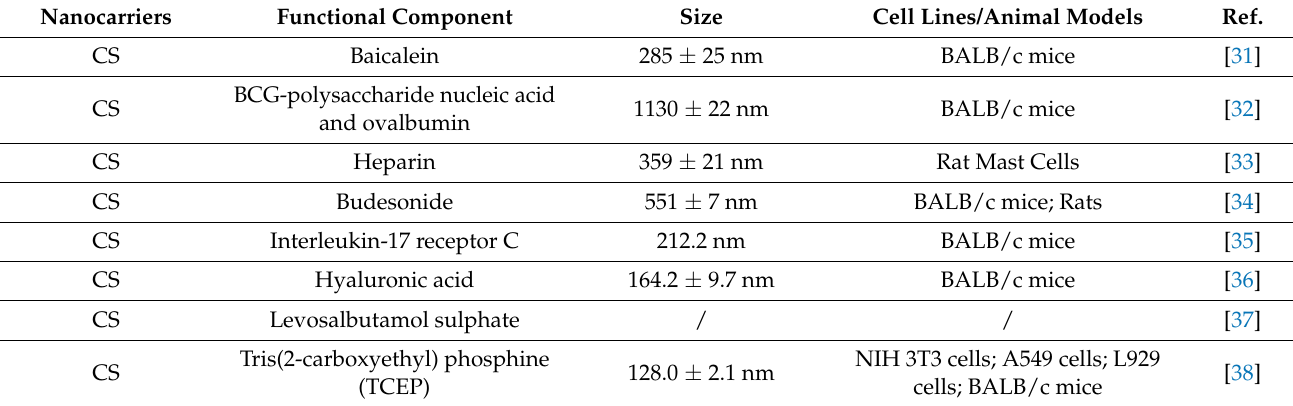
Table 1. Summary of the application of polymers in asthma.